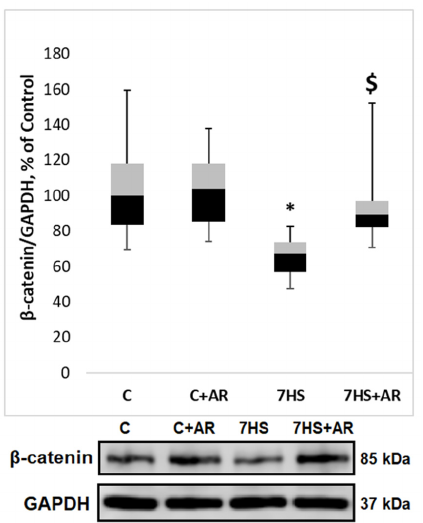
Figure 3. Effect of GSK-3 inhibition during 7-day unloading on β -catenin content in rat soleus muscle. Data are presented as median, interquartile range, minimum and maximum values, expressed as % of control. C, vivarium control group, C + AR, vivarium control rats + daily injections of GSK-3 inhibitor (AR-A014418) for 7 days, 7HS, hindlimb suspension for 7 days, 7HS + AR, 7-day hindlimb suspension + daily injections of GSK-3 inhibitor (AR-A014418), *: p < 0.05 vs. C, $: p < 0.05 vs. 7HS.